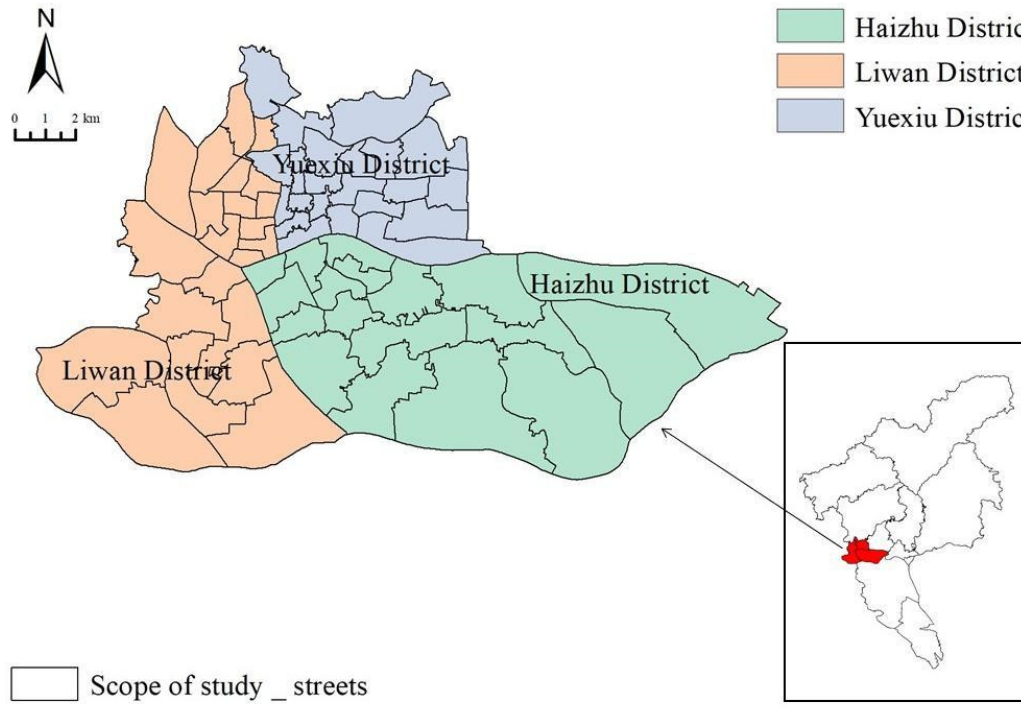
Figure 1. Scope of Research Area.